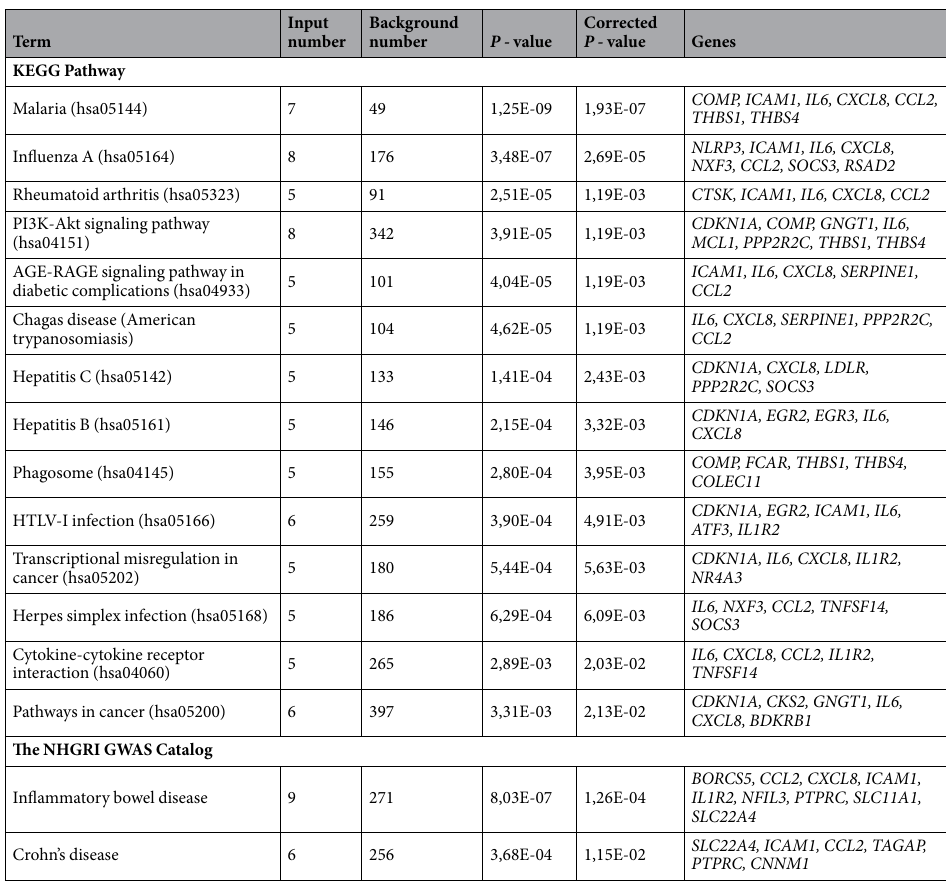
Table 3. The results of gene set enrichment analysis for shared genes up-regulated in POP